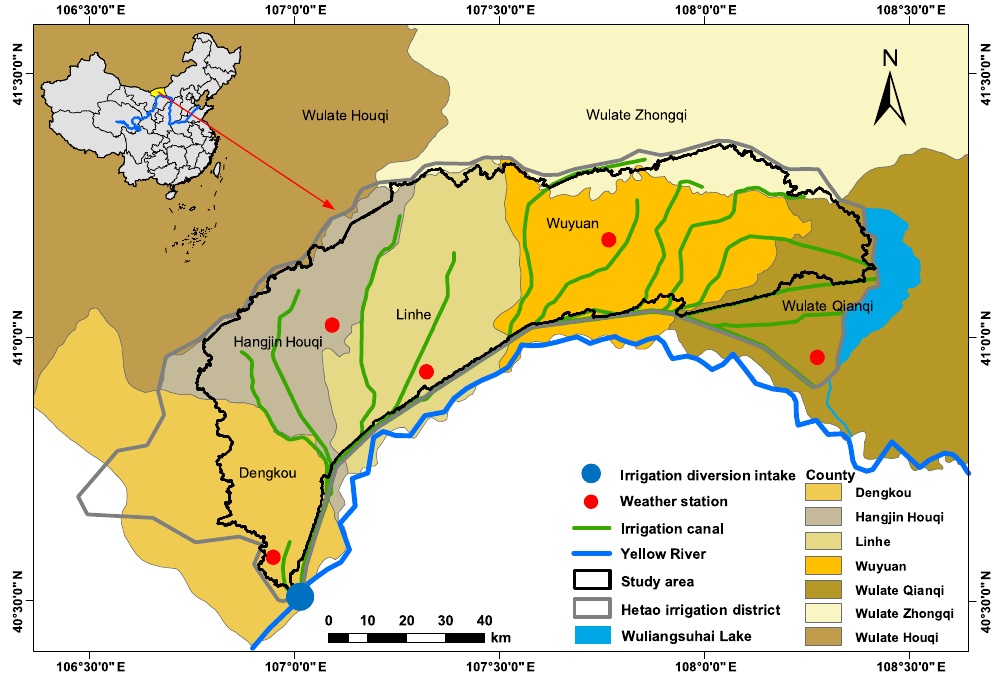
Figure 1. Location of the Hetao irrigation district (HID) in